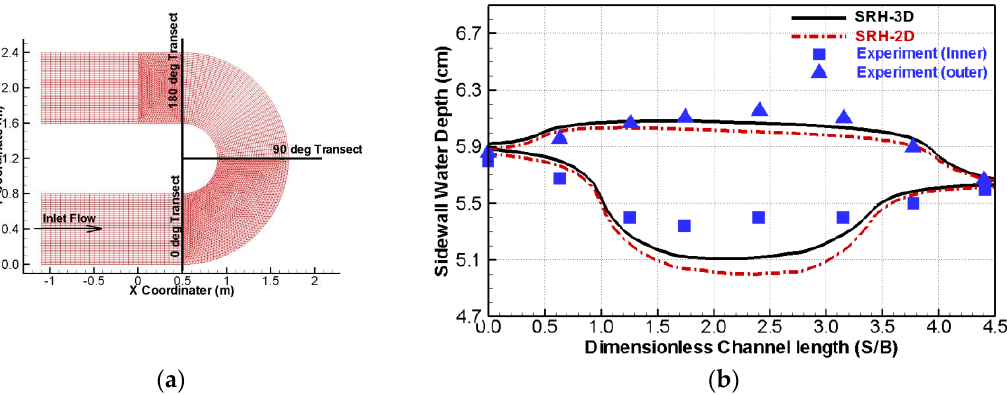
Figure 5. Model domain and the horizontal mixed mesh ( a ) and a comparison of the water depth along the inner and outer sidewall for the bend case ( b ).